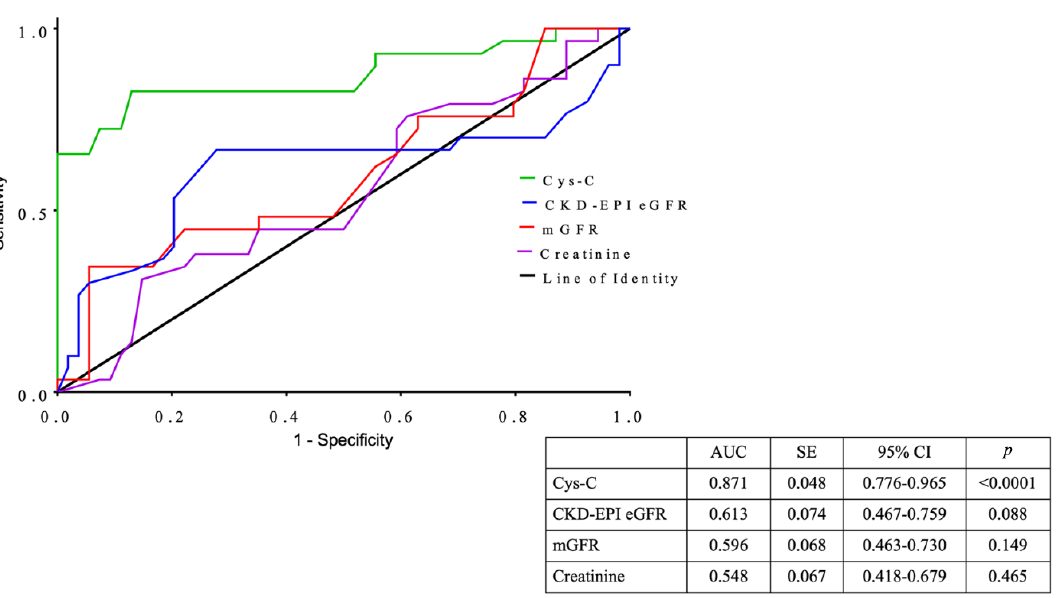
Figure 3. Pearson’s correlation analysis between TSH and Cystatin C in the subgroup with TSH values > 2 µIU/mL ( a ), and in the subgroup with TSH values ≤ 2 μIU/mL ( b ).